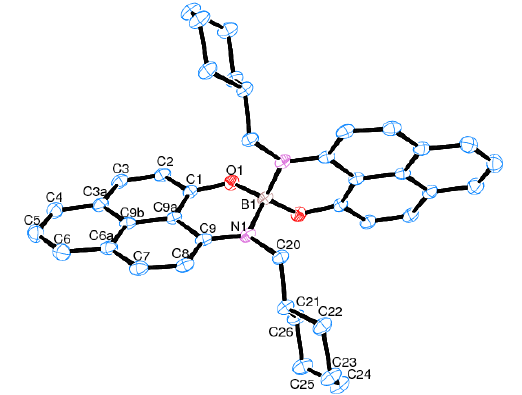
Figure 2. ORTEP drawing of the radical 11 with atom numbering